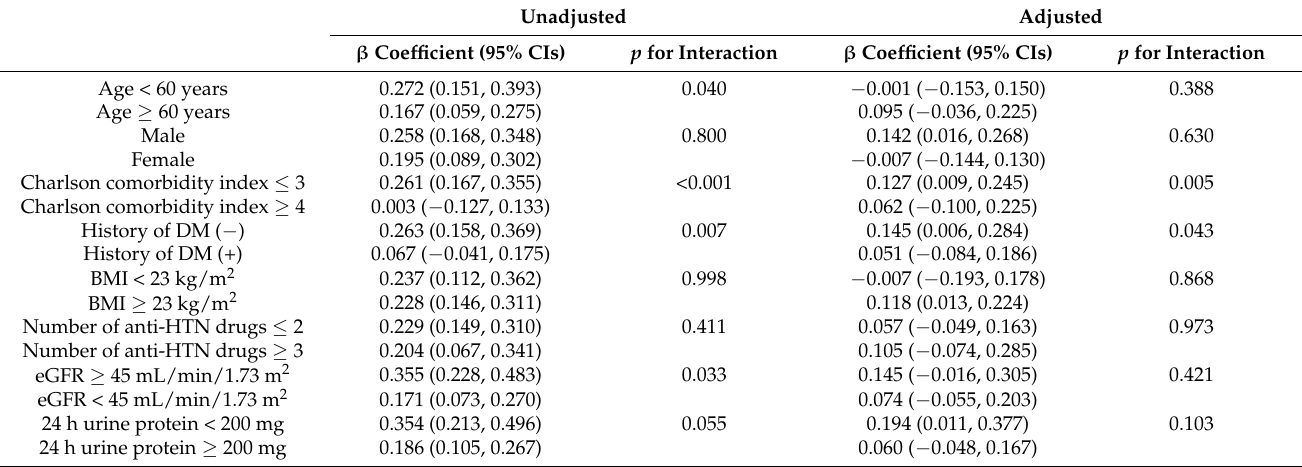
Table 5. Multivariate linear regression analyses of serum OPG level (per pmol/L) for SD of SBP in various